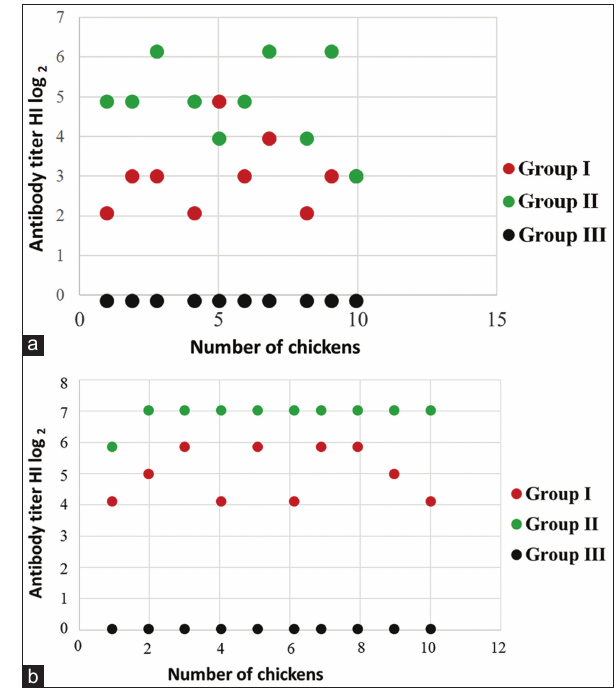
Figure-2: Profile of Newcastle disease virus (NDV) maternally derived antibody of commercial layer chicken at 2 weeks old (a) and 3 weeks old (b). Note: Antibody titers >3 log HI units, which are believed to be able to protect 2 against NDV.